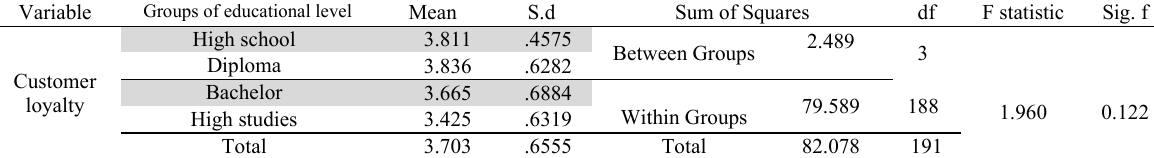
ANOVA test for differences in customer loyalty due to educational level